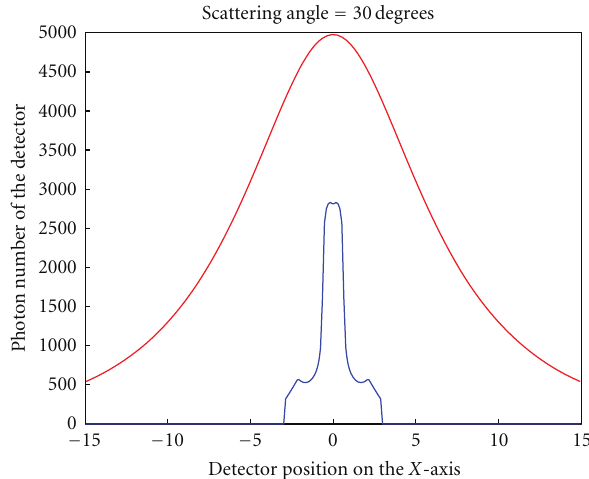
Figure 14: Comparison of the PSF with (lower blue line) and without collimator (upper red line), (reprinted with permission from